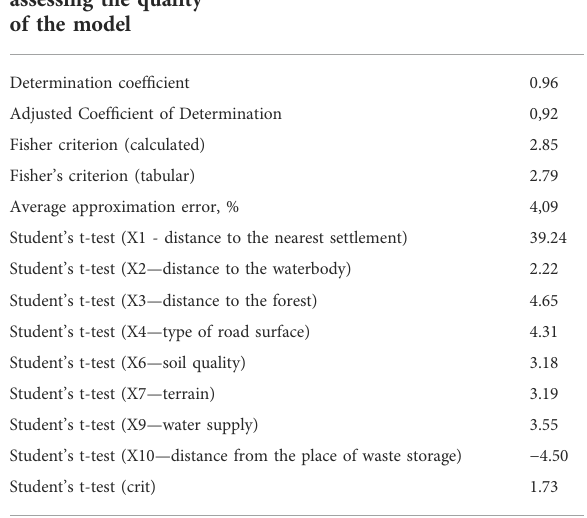
TABLE 4 Analysis of the quality of the resulting model. The name of the criterion for assessing the quality of the